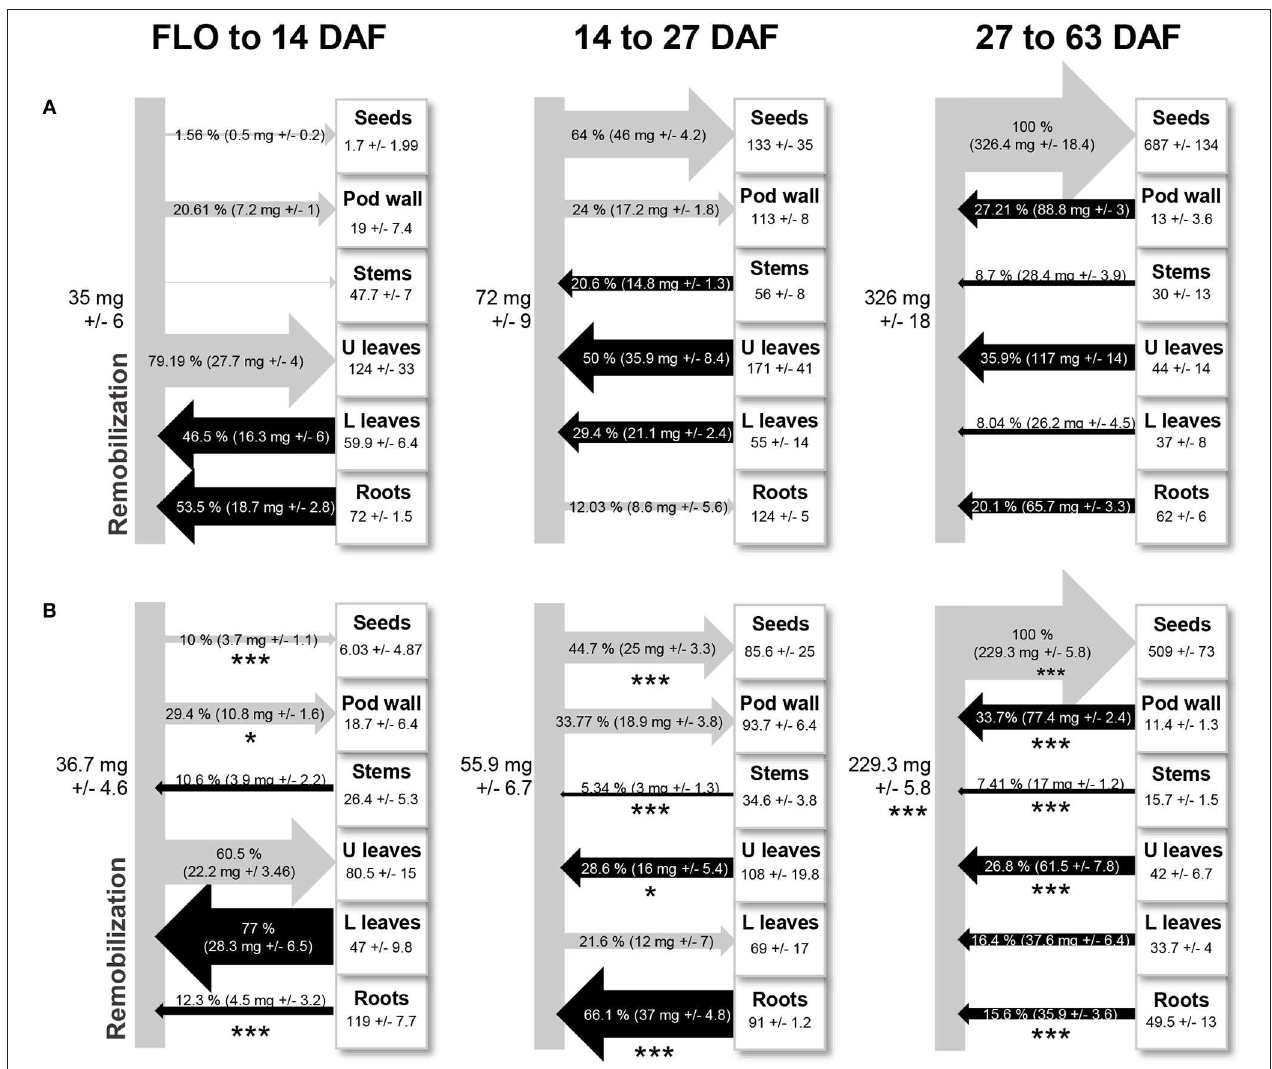
FIGURE 1 | Nitrogen remobilized between plant parts during the reproductive phase in pea, with (A) or without (B) nitrate supply from flowering. Black arrows indicate that nitrogen is remobilized from a tissue, and gray arrows indicate that nitrogen is redistributed toward a tissue. In squares are mean values of nitrogen quantity in each compartment (roots, leaves of the vegetative nodes = L leaves, leaves of the reproductive nodes = U leaves, stems, pod wall, and seeds) at the last stage (14, 27, and 63 days after flowering). Data are mean values ± standard errors. In each diagram and for each tissue, stars indicate significant variations in the amount of nitrogen remobilized in response to nitrogen deprivation: * P < 0.1, ** P < 0.05, *** P < 0.01 ( t -test, data from 4 individual